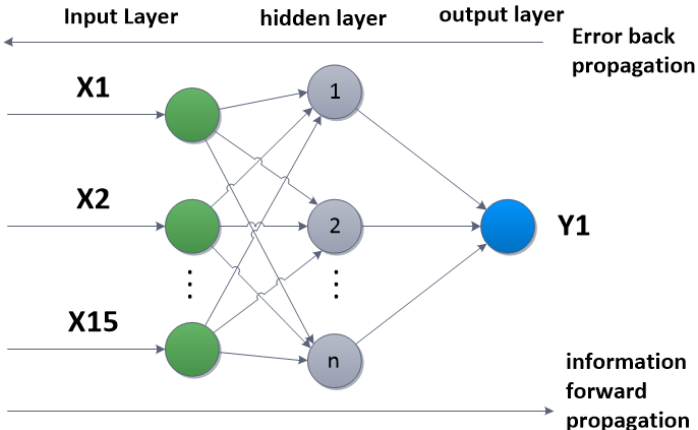
Figure 4. BP neural network topology.